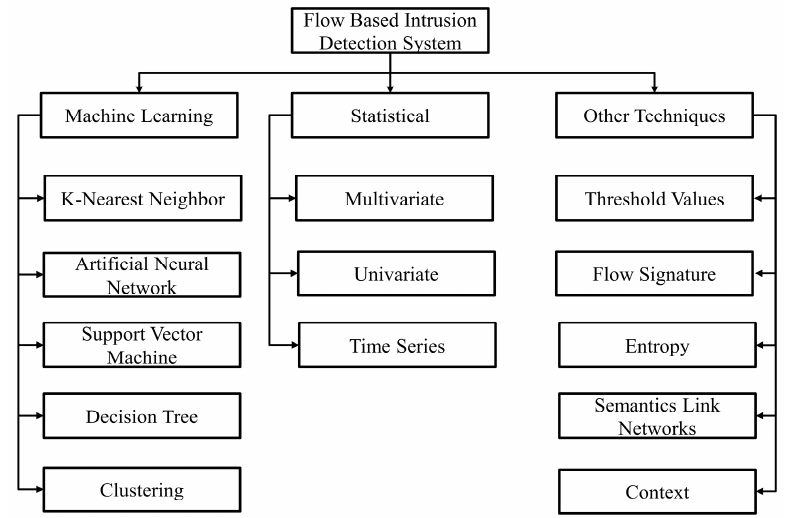
Figure 1. Classification of Flow-Based Intrusion Detection Systems.